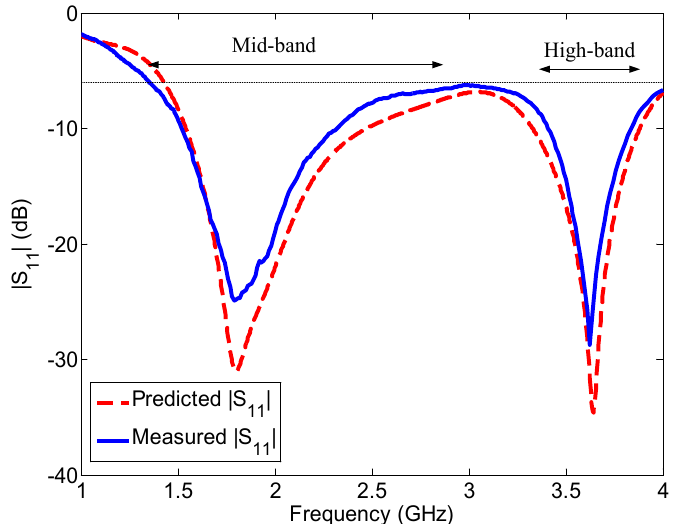
Figure 17. Measured and predicted reflection coefficients of the wideband antenna (Ant#3).